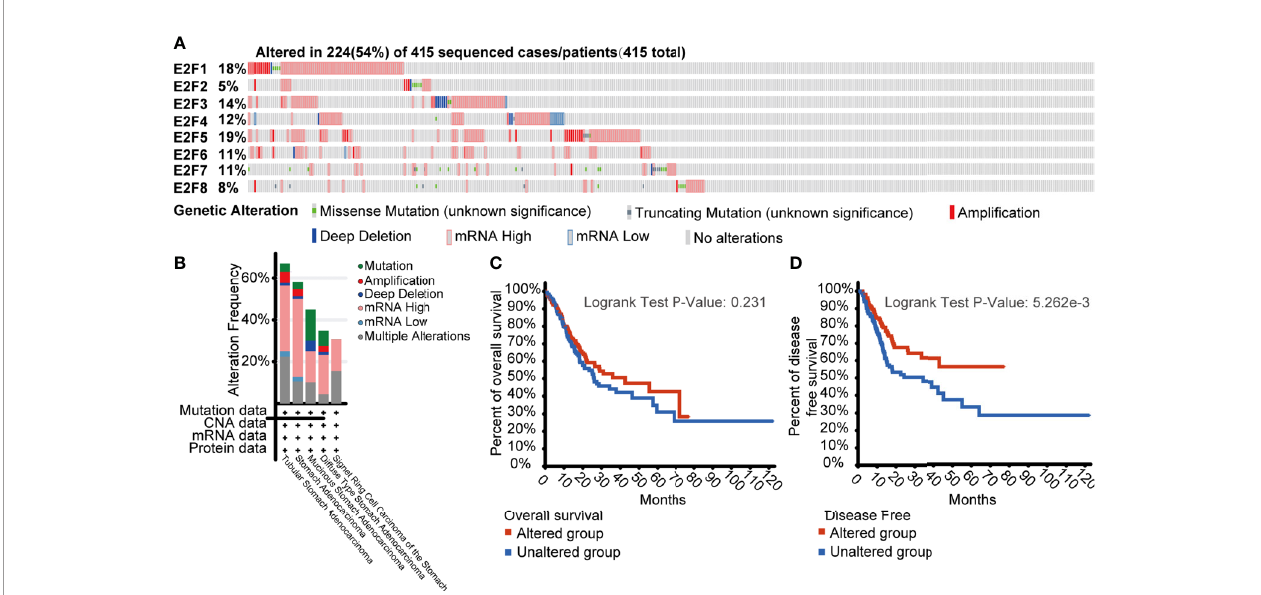
FIGURE 6 | Gene mutations of E2Fs and their signi fi cance in overall survival (OS) and disease-free survival (DFS) of STAD patients (cBioPortal). (A) Analysis of gene mutations of E2Fs in GC. A total of 415 patients with STAD were analyzed, and gene mutations were found in 224 (54%) patients. E2F5 , E2F1 , E2F3 , and E2F4 had the highest gene mutation percentages (19%, 18%, 14%, and 12%, respectively). (B) Cancer types summary of mutations in E2Fs. Patients with tubular STAD were the most likely to have gene alterations of E2Fs (67.11% of 76 cases). (C) Kaplan-Meier OS curve by E2Fs gene mutations status. (D) Kaplan-Meier DFS curve by E2Fs gene mutations